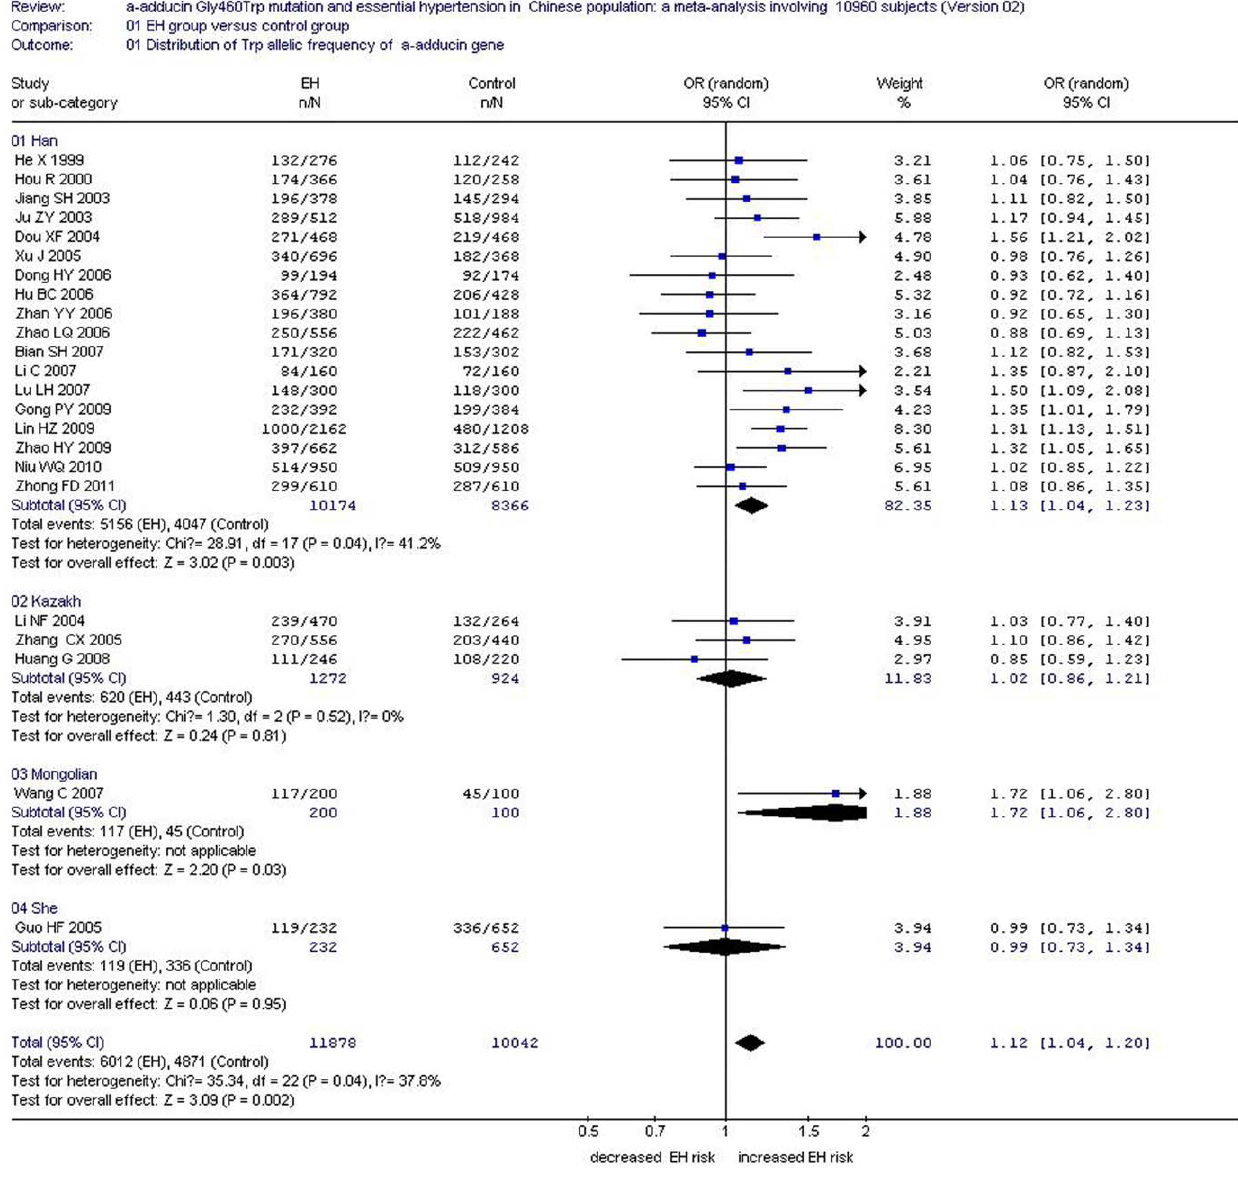
Figure 2. Forest plot of essential hypertension associated with a -adducin Gly460Trp gene polymorphism under an allelic genetic model (distribution of Trp allelic frequency of a -adducin gene) stratified by ethnicity.